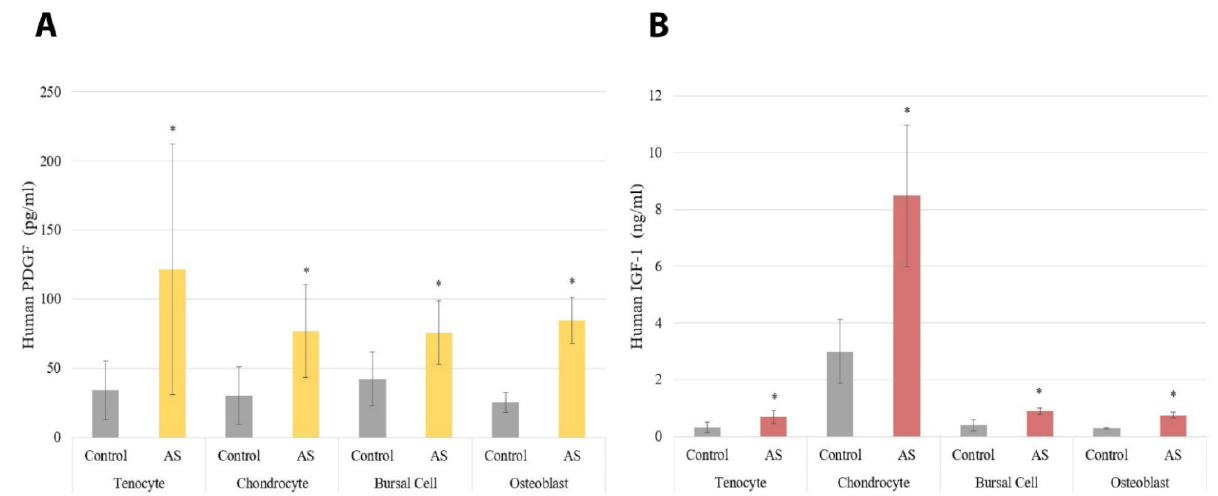
Figure 2. The protein expression of platelet ‐ derived growth factor (PDGF) was significantly in ‐ creased in all cells treated with activated serum compared to control, which can be observed in part ( A ). The protein expression of insulin ‐ like growth factor 1 (IGF ‐ 1) was significantly increased in all cell lines treated with activated serum compared to control, which can be observed in part ( B ). Statistical significance ( p < 0.001) denoted by *. AS, Activated Serum.